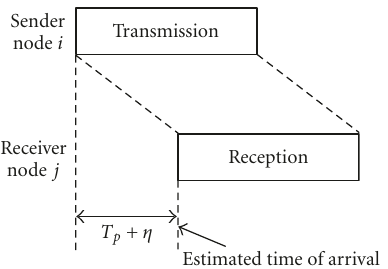
Figure 2: MAC layer-based time delay